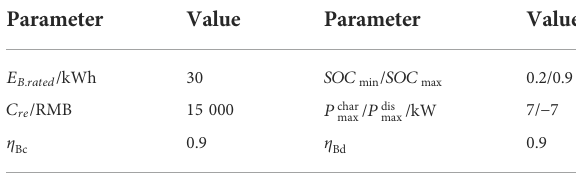
TABLE 1 Random parameters of various EV